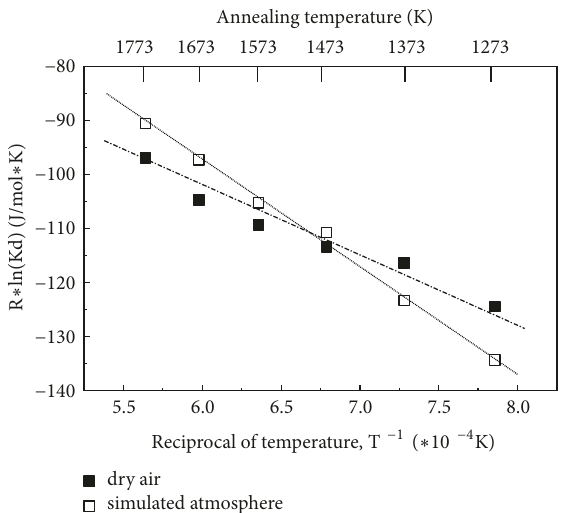
Figure 5: Arrhenius equation plot of oxide rate for KD-S fibres in simulated atmosphere and dry air.